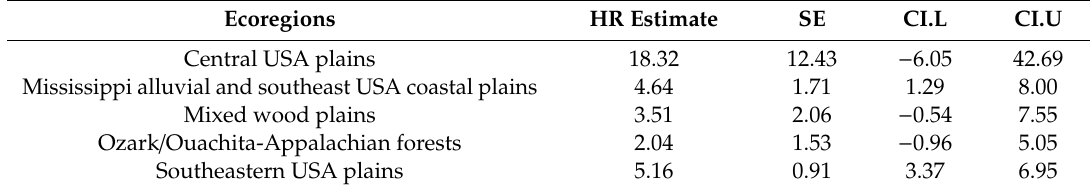
Table 2. Raw mean HR estimates with standard error (SE) and 95% confidence intervals (CI.L and CI.U) for all T. carolina studies, by ecoregion.